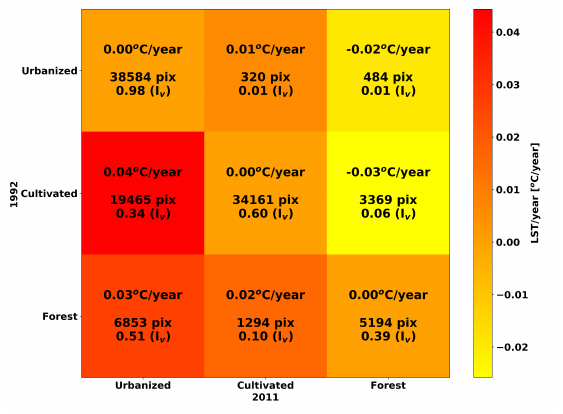
Figure 15. Chicago MA: Detrended Rate